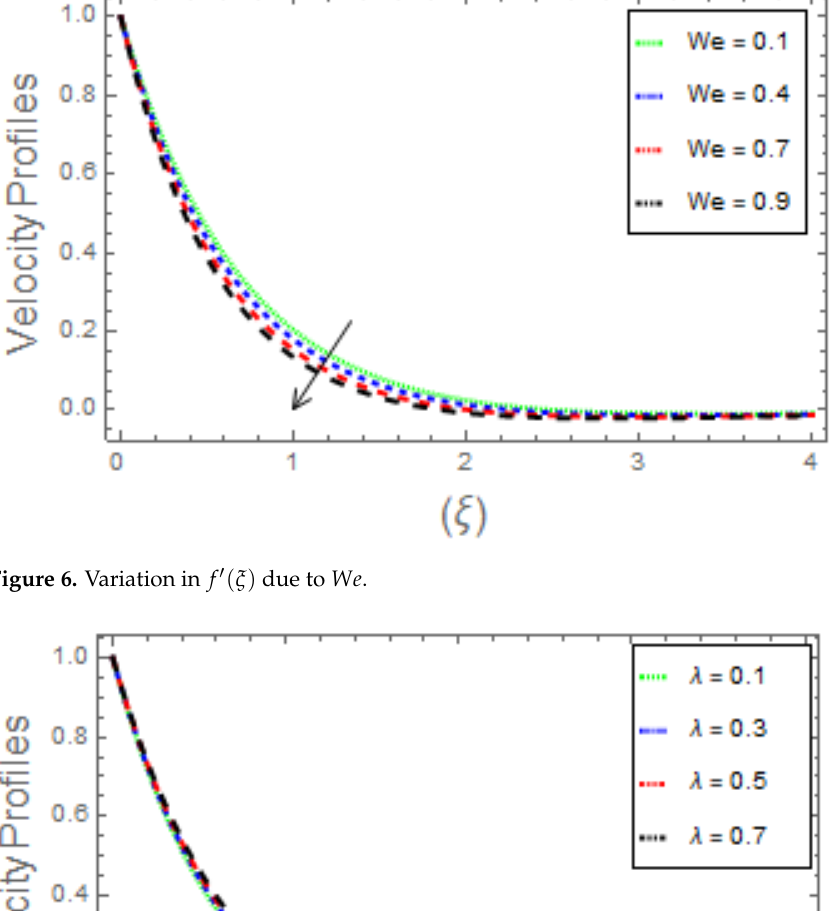
( ) (cid:48) ( ξ ) due to λ ' f ξ due to λ . Figure 7. Variation in f ( ) ' f ξ due to λ .